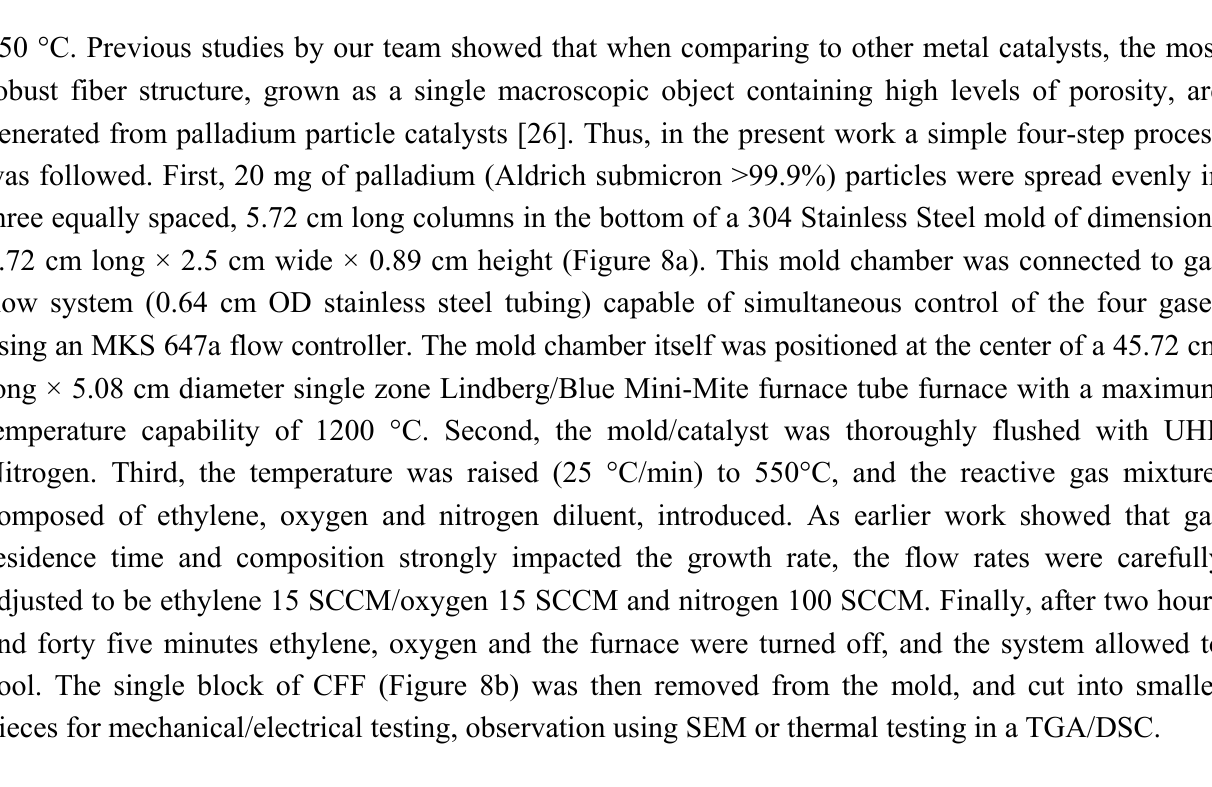
Figure 8. Steel mold and catalyst geometry. Arranging Pd catalyst particles in the mold as shown ( a ), was found to be a necessary part of the protocol required to create, based on visual inspection, homogenous CFF ( b